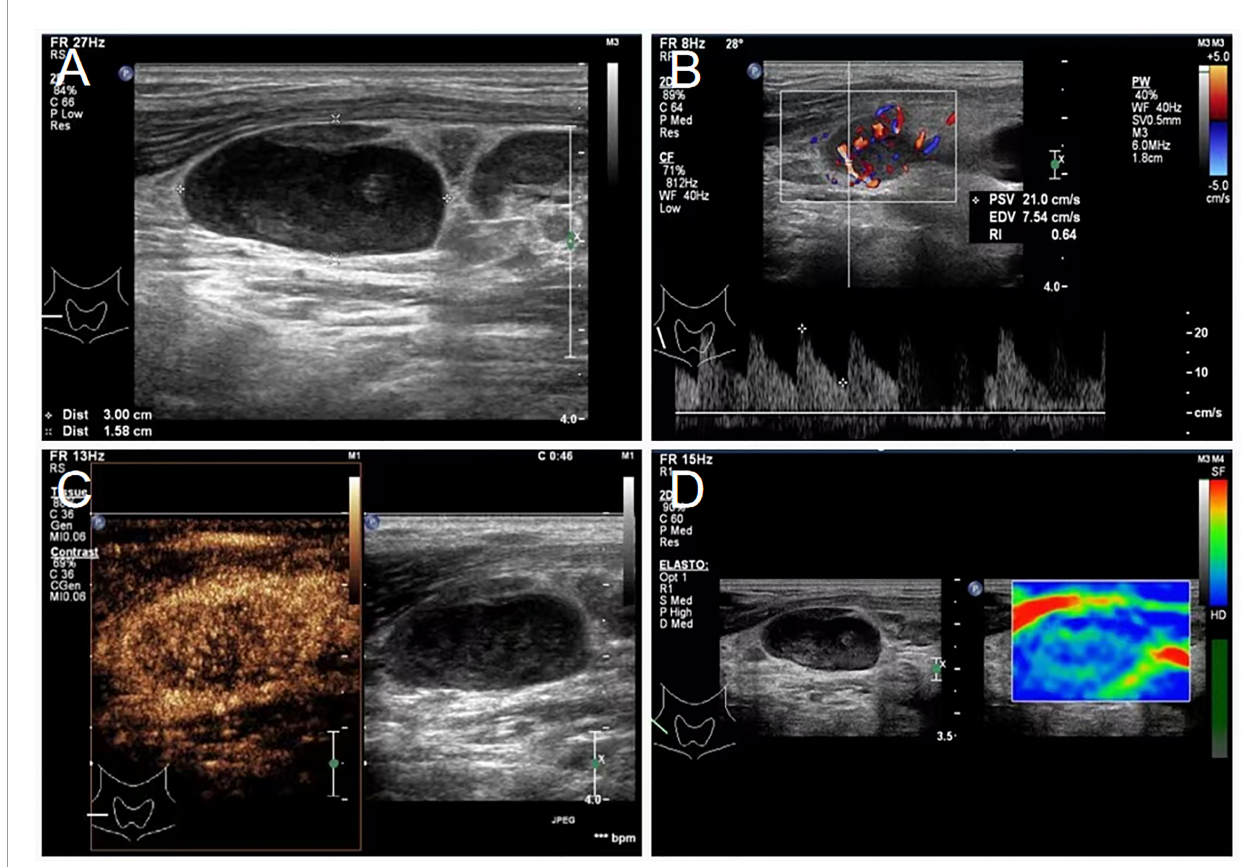
FIGURE 1 | Lymphadenopathy notedonultrasound in the neck of a 43-year-old malepatient diagnosedwith primary mediastinal B-celllymphoma. (A) Sonogram revealing enlargedlymph nodes of the right neck, 3.0 × 1.6 cm insize, oval, uneven,and with a fair margin. (B) Color Doppler examination showing abundant blood fl ow in enlarged lymph nodes ofthe right neck, a lymphatichilum,PSV: 21.0 cm/s, RI: 0.64. (C) Contrast-enhanced ultrasound showing abundant lymph nodeblood supply in area III of the right neck. (D) Shear-wave elastography of the lymph node, which isindicated bythe mostlyblue area. PSV, peak systolicvelocity;RI, resistance